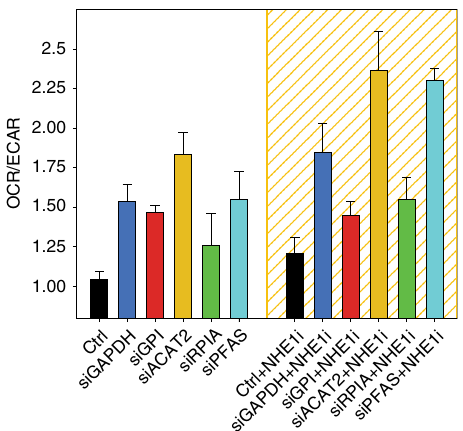
Fig. 5 Anti-Warburg effects of lowering pHi and inhibition of pHi- dependent metabolic targets. Seahorse fl ux experiments were preformed for MCF7 naïve cells under normoxia, with (low pHi, yellow grid) and without (physiological pHi) inhibition of NHE1 and of the indicated metabolic targets. The reduction in pHi (black bars) has an anti-Warburg effect on cancer cell metabolism, as measured by the ratio between the oxygen consumption rate (OCR) and the extracellular acidi fi cation rate (ECAR). Both at physiological pHi and at low pHi the additional inhibition of the selected targets (colors), ampli fi es the anti-Warburg effect on cancer cells. Highest OCR/ECAR ratios are obtained at low pHi (yellow grid). Seahorse experiments were done in six replicas each time and experiments were repeated three times. The bars depict the mean and the error bars depict the standard deviation of the